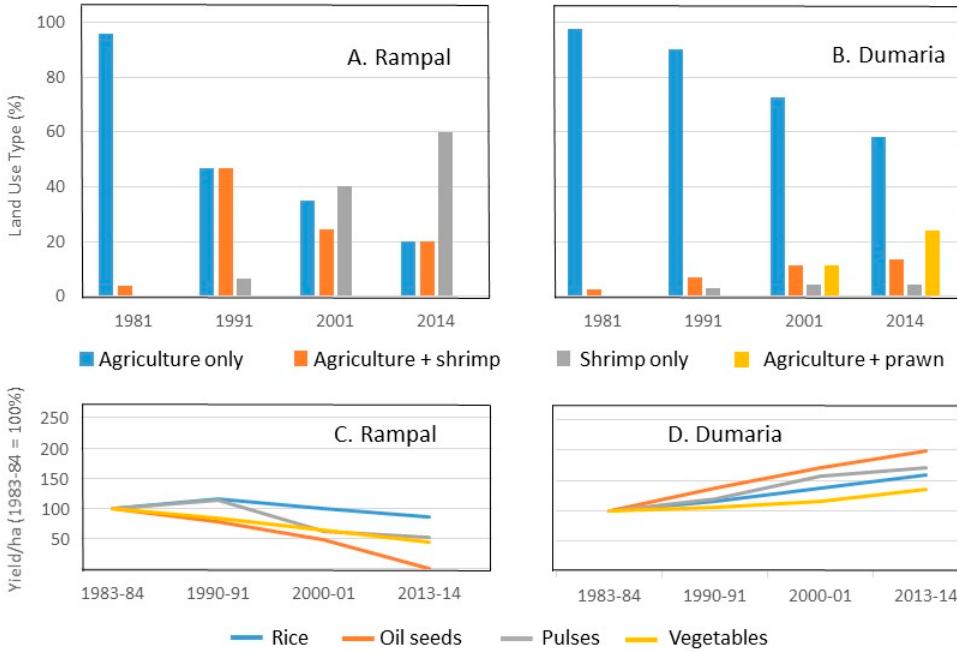
Figure 2. Changes in land use between 1981 and 2014 in the Rampal ( A ) and Dumaria ( B ) sub-districts of Bangladesh as well as trends in crop production / ha in Rampal ( C ) and Dumaria ( D ) from 1983–1984 to 2013–2014. The original data are from Islam and Tabita [89].